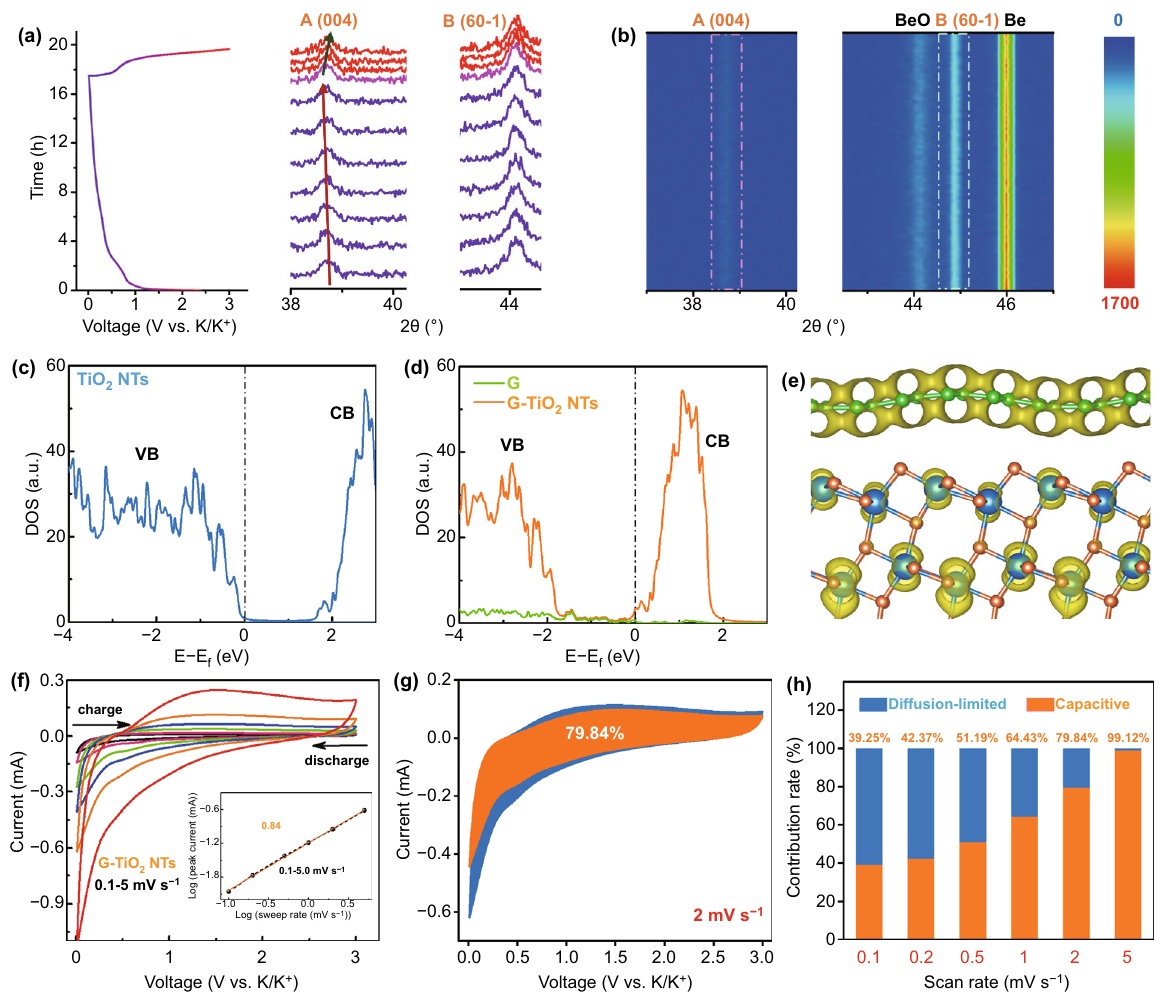
Fig. 4 Operando XRD, first‑principle calculations and kinetics analysis of G‑TiO 2 NTs for potassium storage. a The first discharge–charge curve and corresponding operando XRD patterns, showing the signal change of key diffractions with K metal serving as the counter electrode. b Contour maps for XRD data collected during the first cycle. c , d Calculated density of states (DOSs) for the c) TiO 2 and d) G‑TiO 2 system. The black dashed line indicates the Fermi level. e Partial charge density around the Fermi level of 0.05 eV by using yellow contour with the iso‑ surface value of 0.0001 eV/bohr 3 . Ti, C, and O atoms are in blue, green, and orange color, respectively. f CV curves of G‑TiO 2 NTs at different scan rates from 0.1 to 5.0 mV s −1 . Inset: b ‑value determination from the relationship between the peak currents and the scan rates. g Separation of the pseudocapacitive contribution (the orange region) for G‑TiO 2 NTs at a CV scan rate of 2 mV s −1 . h Bar chart depicting the percentages of pseudocapacitive contributions at different scan rates from 0.1 to 5 mV s